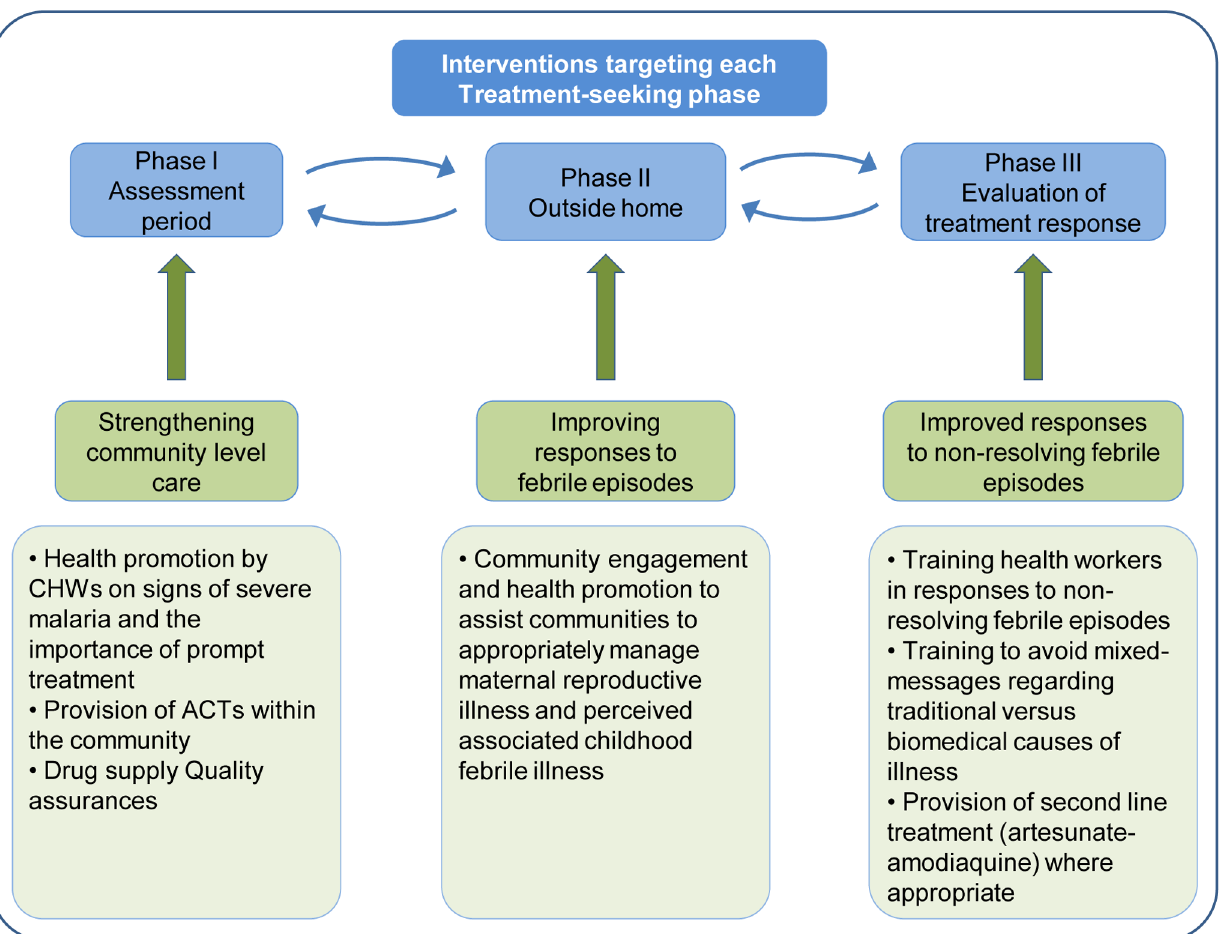
Fig 2. Interventions targeting each treatment-seeking